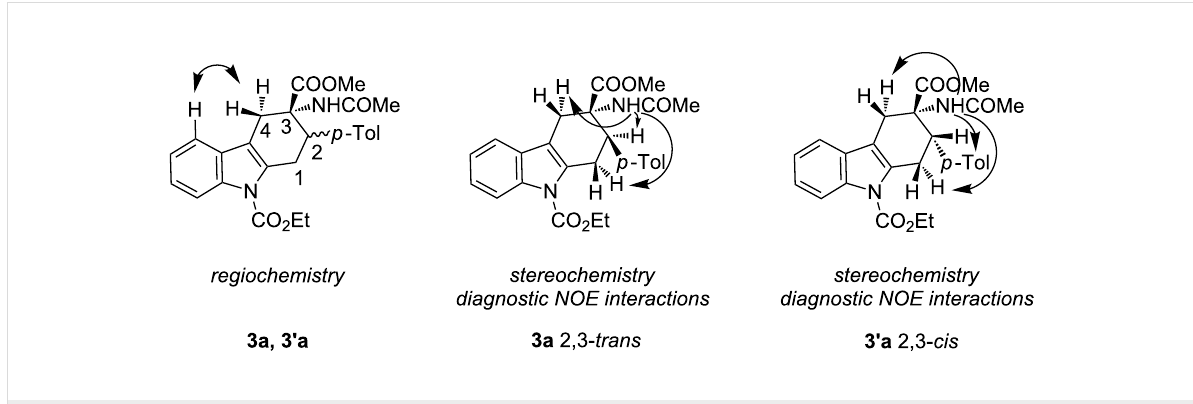
Figure 3: Structure elucidation of diastereoisomeric tetrahydrocarbazoles 3a and 3’a via NMR experiments.